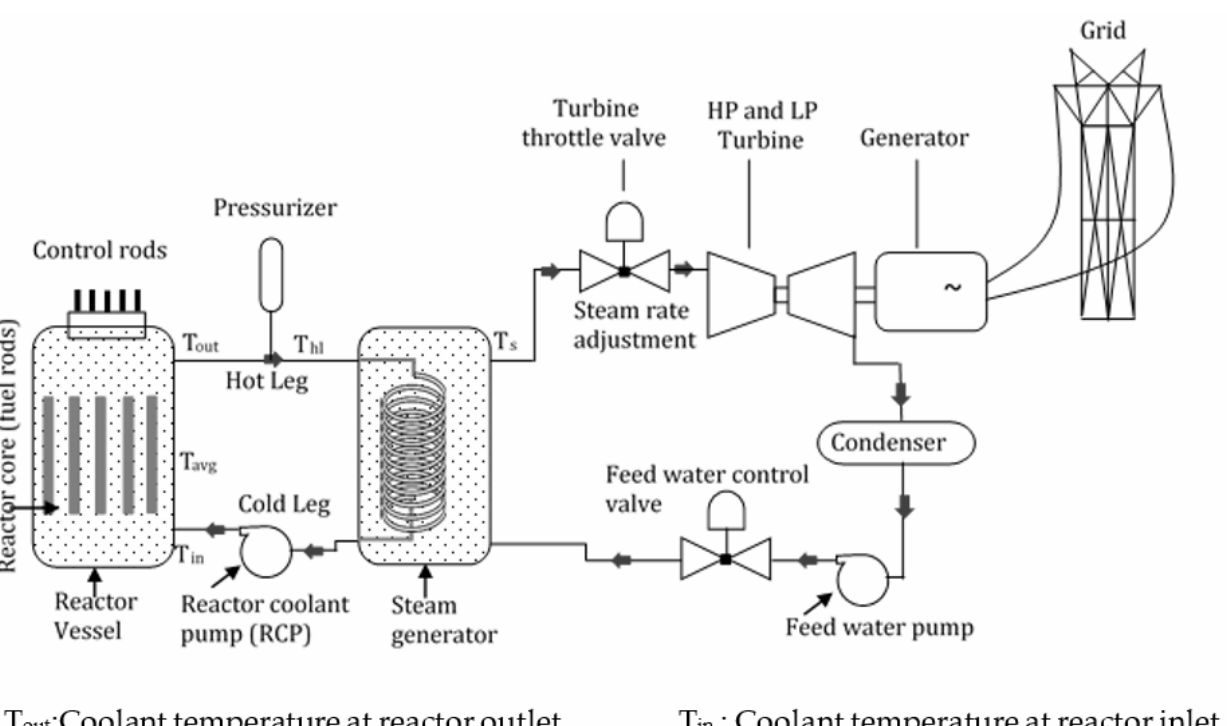
Figure 1. Schematic of PWR Nuclear Power Plants.